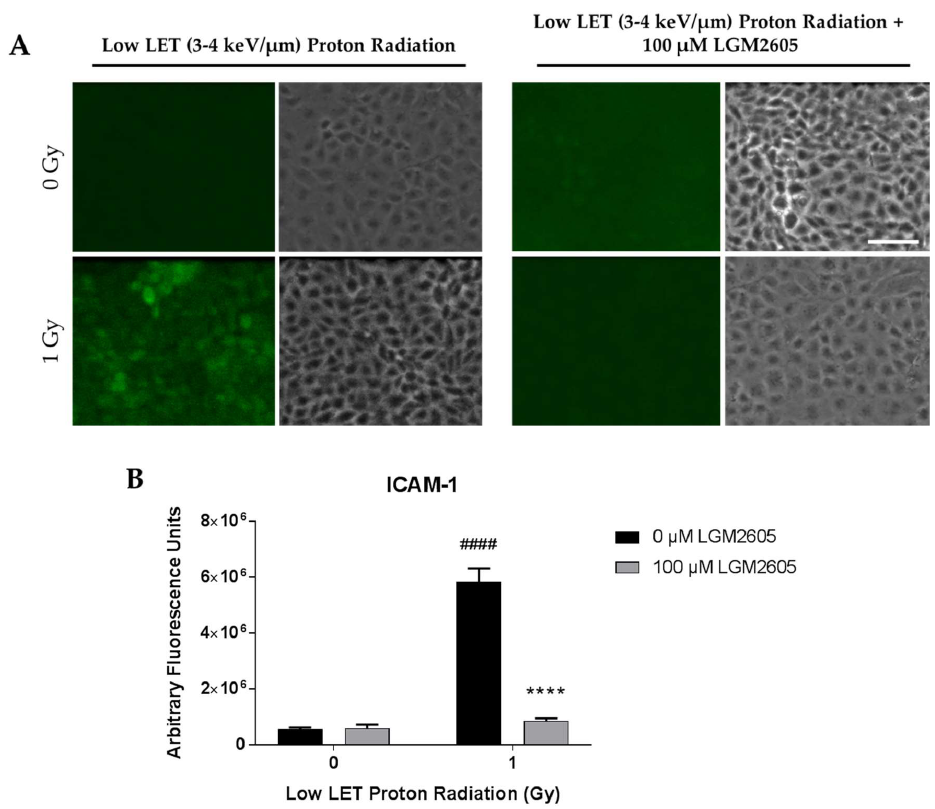
Figure 4. Evaluation of LGM2605 inhibition of ICAM-1 expression in in vitro lung vascular